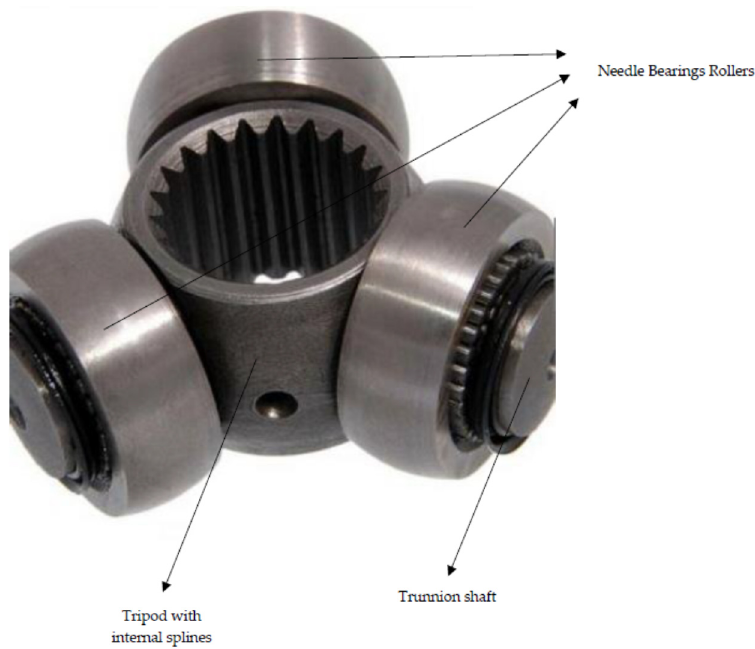
Figure 5. Details of a Tripod.